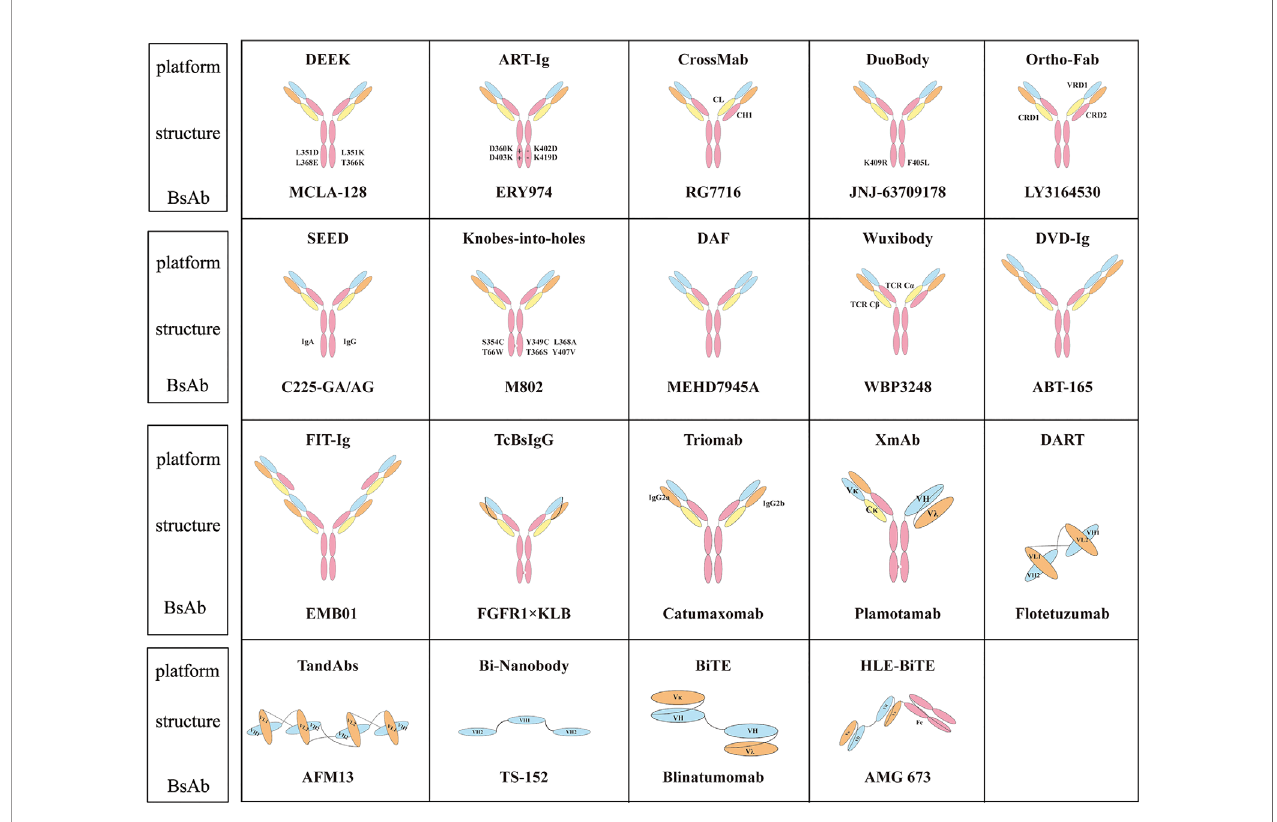
FIGURE 1 | Classical molecular platform of BsAbs and representative